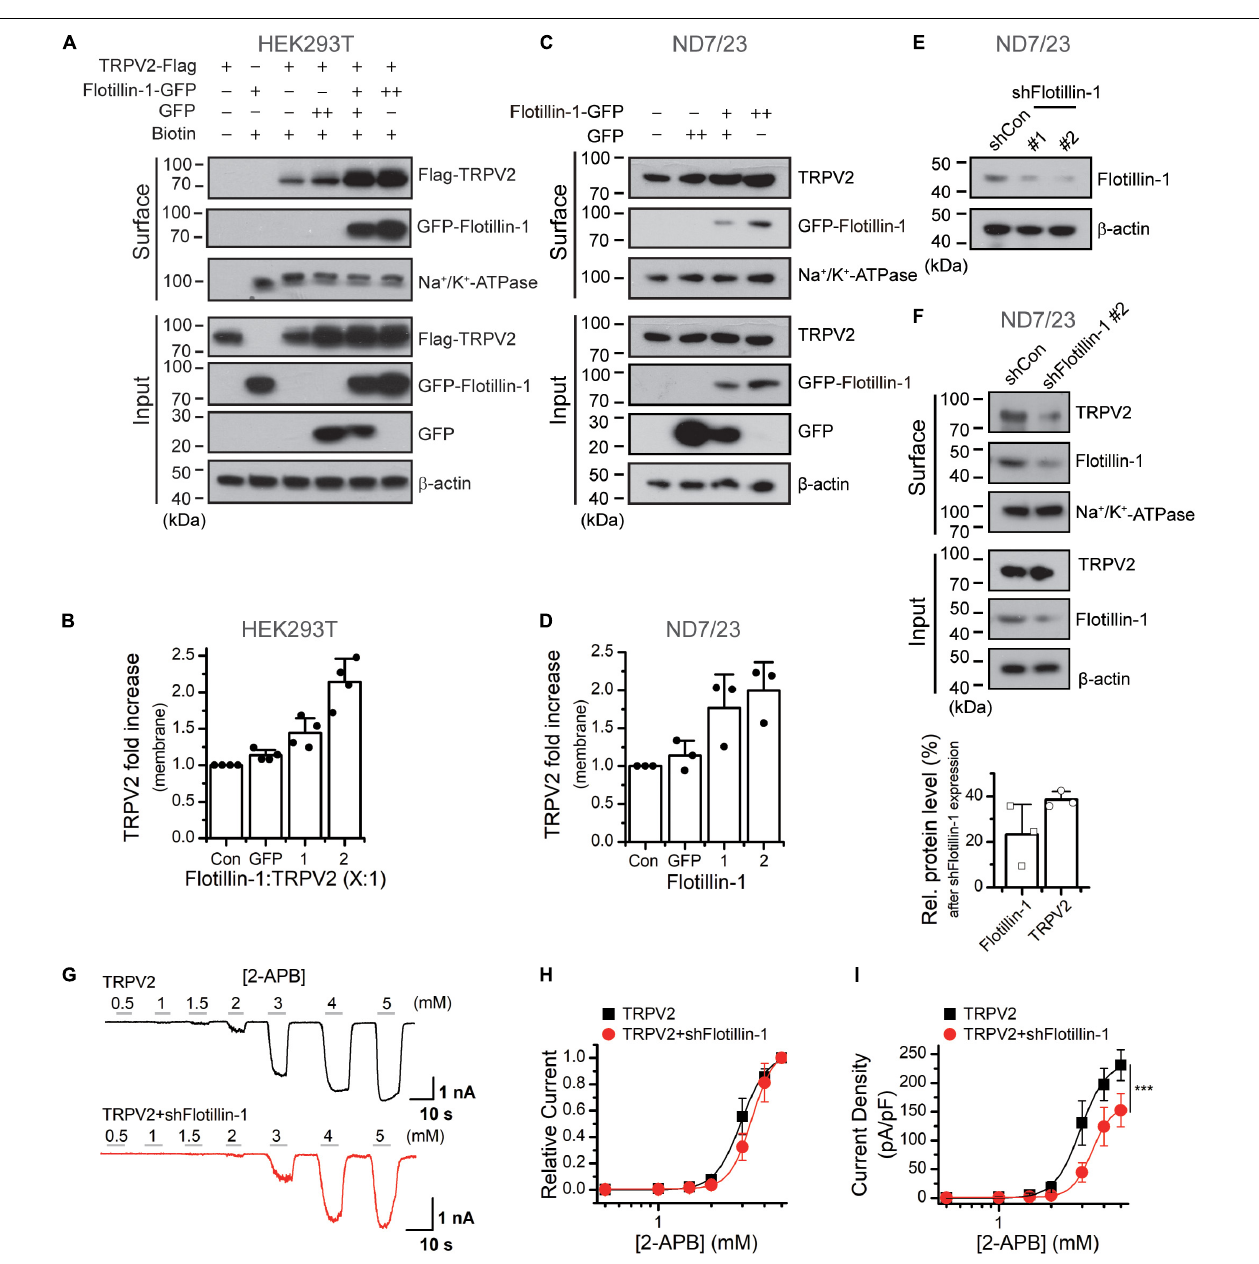
FIGURE 4 | Flotillin-1 enhances the surface expression levels of TRPV2. (A) Increased surface expression of TRPV2 by flotillin-1. HEK 293T cells were transiently transfected with TRPV2 with GFP or increased flotillin-1 as indicated. Surface levels of TRPV2 were measured by IB after plasma membrane proteins were biotinylated and purified with NeutrAvidin agarose beads. β -actin and Na + /K + ATPase were used as controls for cytoplasmic and membrane proteins, respectively. (B) Quantitative analysis of the fold increase of TRPV2 on the plasma membrane by co-expression with flotillin-1 in HEK 293T cells ( n = 4; means ± SD). (C,D) ND7/23 cells were transiently transfected with increasing amounts of flotillin-1-GFP cDNA. Similarly, surface levels of TRPV2 were measured by IB after plasma membrane proteins were biotinylated and purified with NeutrAvidin agarose beads. Blots are representatives of three independent experiments. Error bars represent SD. (E) Immunoblot analysis (with anti-flotillin-1) of ND7/23 cells transfected for 36 h with plasmids encoding flotillin-1-targeting shRNA (shFlotillin-1 #1, and shFlotillin-1 #2) or control shRNA (shCon) to test efficiency of shRNA. (F) Effect of knocking down flotillin-1 on the surface expression of TRPV2 in ND7/23 cells. The cell surface biotinylation assay was used to measure the surface levels of TRPV2 in ND7/23 cells that were stably transfected with shCon or shFlotillin-1 #2. Below showing the quantitative analysis of the relative protein levels of TRPV2 and flotillin-1 caused by shFlotillin-1 #2. Data are representative of three independent experiments. (G) Whole-cell recordings in HEK 293T cells expressed TRPV2 alone ( upper ), and TRPV2 + shFlotillin-1 ( lower ), showing that 2-APB dose-dependently activated TRPV2 channels. Holding potential was –60 mV. (H) Dose–response curves for 2-APB-evoked currents. Solid lines indicate fits with the Hill equation, which yielded EC 50 = 2.95 ± 0.06 mM, n H = 5.84 ± 0.72 for TRPV2 ( n = 8); and EC 50 = 3.39 ± 0.02 mM, n H = 6.87 ± 0.17 for TRPV2 + shFlotillin-1 ( n = 8). (I) Summary plot of current density. The current densities evoked by 2-APB were determined by normalizing the membrane peak current by membrane capacitance. ( n = 8). *** P <